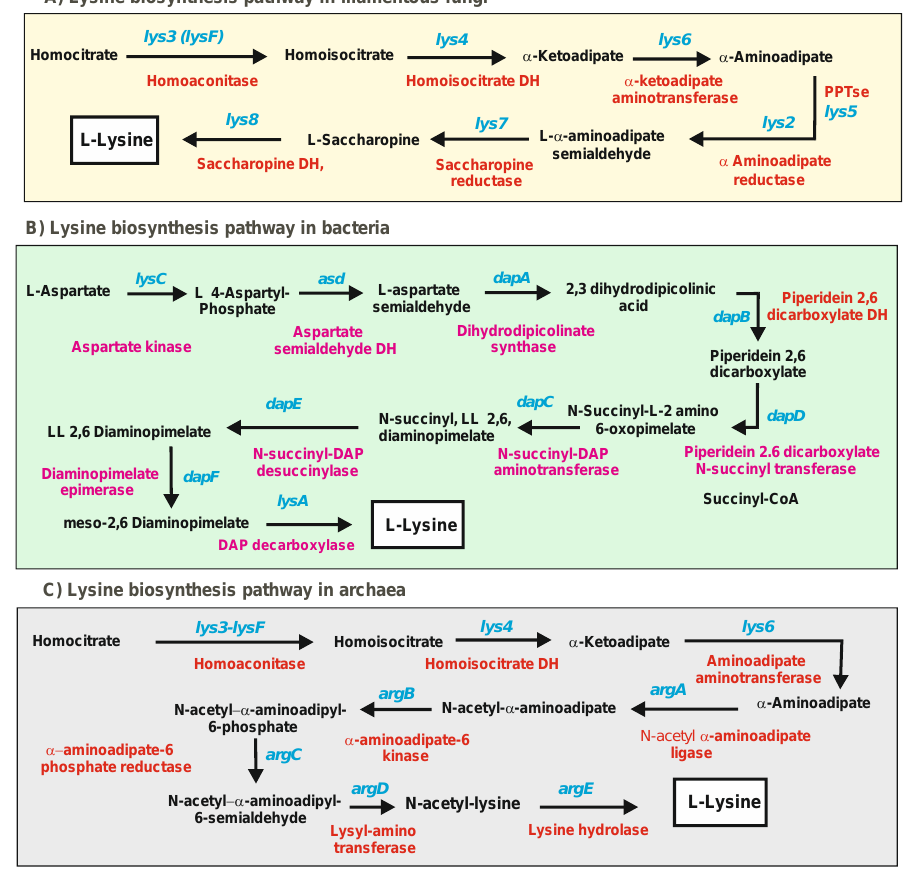
Figure 1. Biosynthetic pathways of lysine. ( A ) In filamentous fungi. ( B ) In bacteria. ( C ) In Thermus thermophilus and archaea. The enzymes involved in each step are indicated in red letters. The genes are indicated in blue letters. Note: For simplicity, the designation of the genes of yeasts and filamentous fungi are used with the three letters in cursive letters in the text. The designation of the genes in all figures refers to the filamentous fungi names published in the literature (not to the yeast names, which are frequently